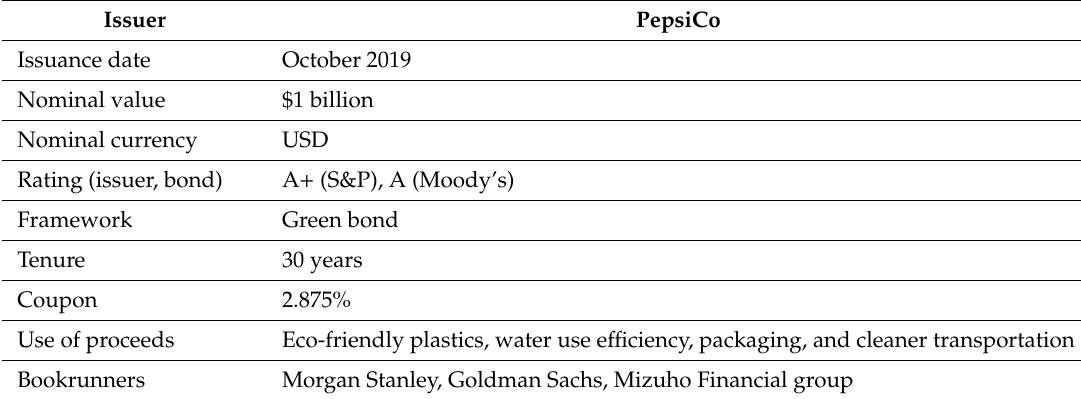
Figure A1. Overview of the green bond supply since 2015. Source: Dealogic, Bloomberg (for munis) as of 20 January 2020. Financials include covered bonds. Table A1. PepsiCo’s green bond.